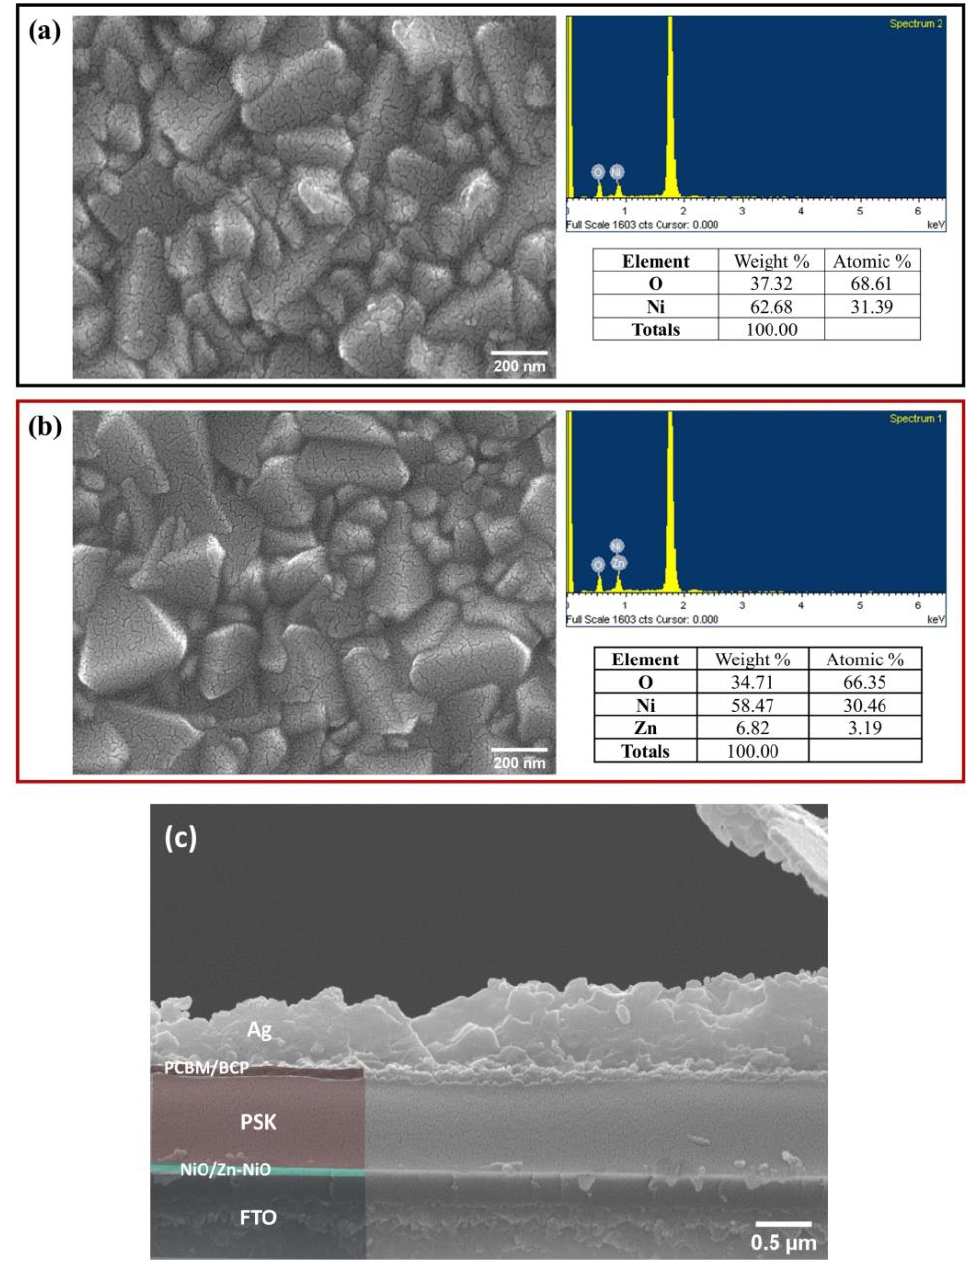
Figure 6. FESEM image and EDS result of ( a ) NiO x and ( b ) 5% Zn-NiO x thin films, ( c ) cross-sectional FESEM image of the device. Figure 7a,b show the AFM images of NiO x and 5% Zn-NiO x thin films annealed at 250 ◦ C. The films exhibited similar smooth and compact surface topography on FTO substrates for both NiO x and 5% Zn-NiO x . The root-mean-squared (RMS) roughness values of NiO x and 5% Zn-NiO x are 37.1 nm and 33.9 nm, respectively. The roughness of the film decreased with Zn doping because of the tendency of ZnO to form a crystalline nature at the lower annealing temperature [42]. This result is well-matched with other literature reports